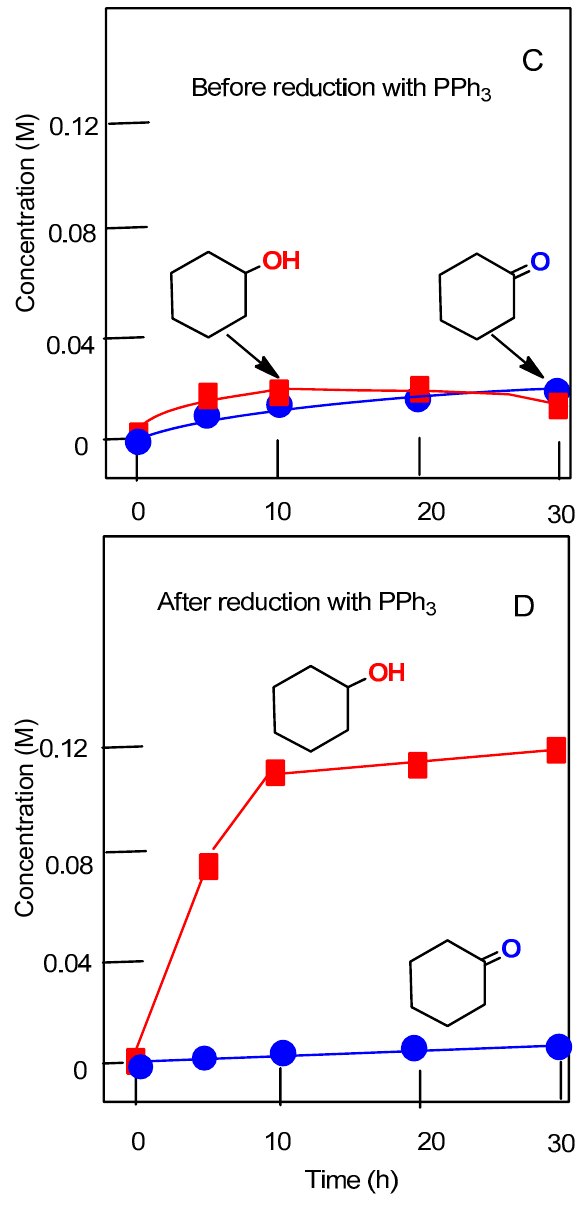
Figure 17. Accumulation of cyclohexanol and cyclohexanone in oxidation of cyclohexane with hydrogen peroxide catalyzed by compound 21 in MeCN at 50 °C. Dependence of the initial rate of oxygenate formation W 0 on initial concentration of cyclohexane is shown in graph ( A ). Linearization of curve from graph ( A ) in coordinates W 0 − 1 —[CH 3 CN]/[C 6 H 12 ] is presented in graph ( B ). Concentrations of cyclohexanone and cyclohexanol were determined after reduction of the aliquots with solid PPh 3 . Accumulation of cyclohexanol and cyclohexanone (under conditions given above) is shown when their concentrations were measured before (graph ( C )) and after treating the reaction sample with PPh 3 (graph ( D )). Adapted from [89], Copyright (2019) with permission of Elsevier.